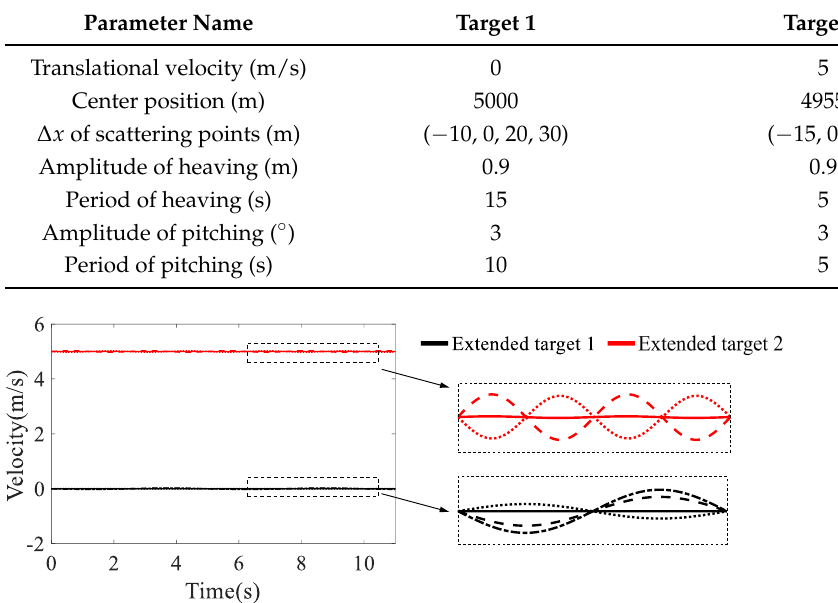
Table 1. The parameters of simulated extended targets.